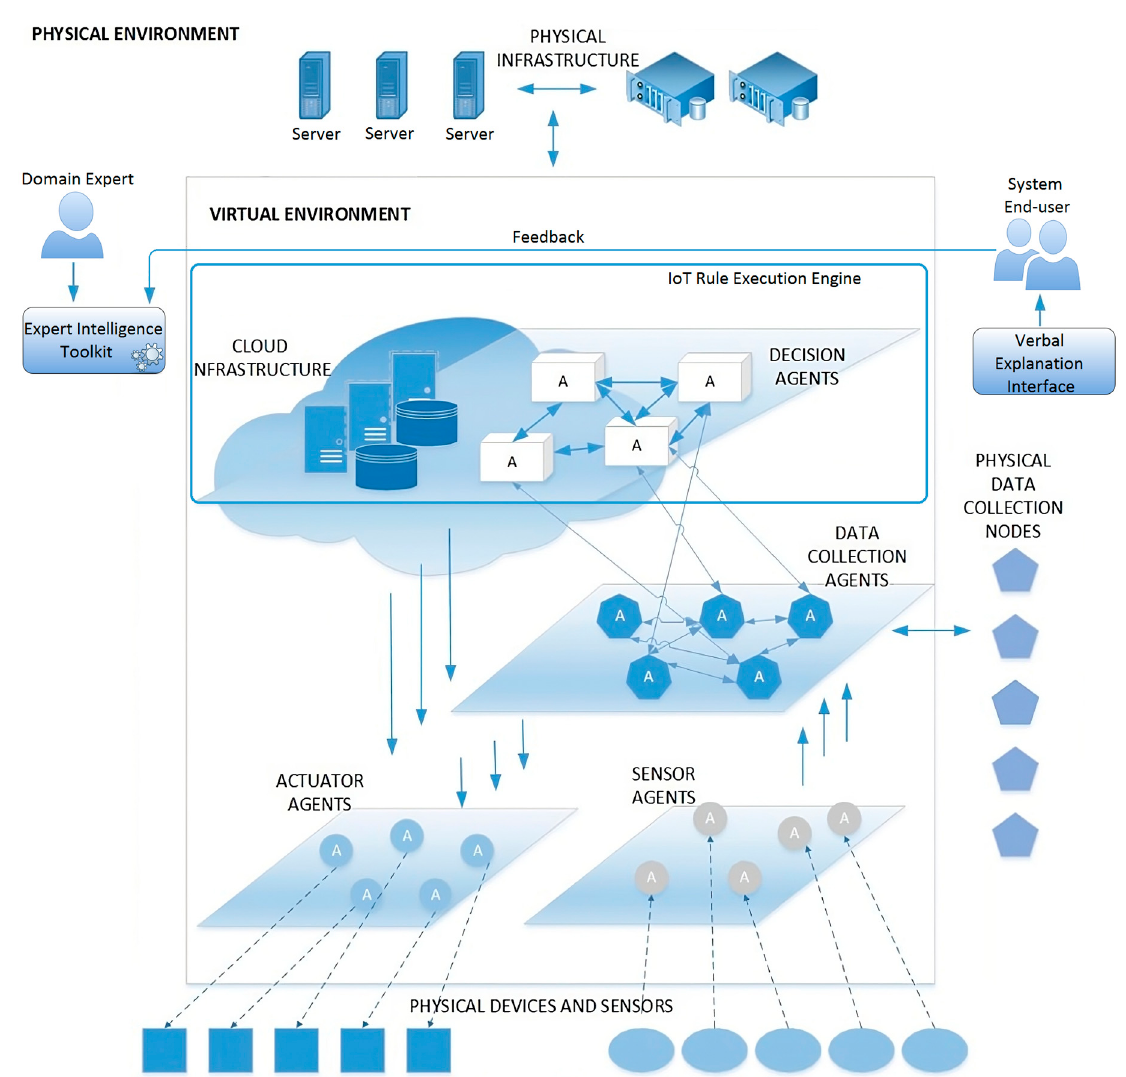
Figure 1. Agent-based IoT system Figure 1. Agent ‐ based IoT system architecture.